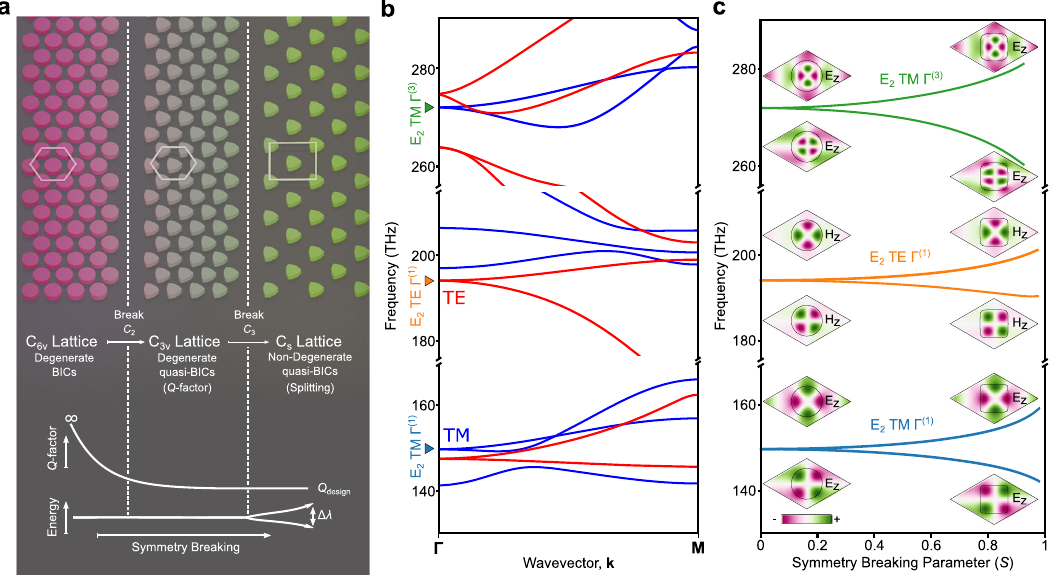
Fig. 1 | Symmetry-protected degenerate bound states in the continuum in tri- angularlattices.a Conceptualdiagramofsymmetry-protecteddegeneratebound states in the continuum. The Q -factor and mode splitting can be independently controlledbybreaking C 2 and C 3 symmetries,respectively. b Bandstructureoftwo- dimensional triangular lattice of dielectric circles ( n =3.5). Degenerate, symmetry- protectedBICsappearatthe Γ -pointat150,195,and270THzdenotedwithtriangle markers. The modes can be categorized as E 2 TM Γ (1) , E 2 TE Γ (1) , and E 2 TE Γ (3) , respectively. Here, the degenerate symmetry-protected BICs at Γ are labeled using the notationE 2 P L ( α ) .Here, P denotes whether the mode isTEor TM, L denotesthe